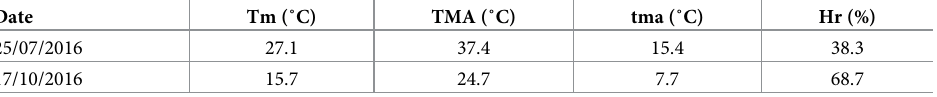
Table 1. Weather conditions of the collection days obtained from the nearest meteorological station to the artifi- cial insemination center were rams were located.